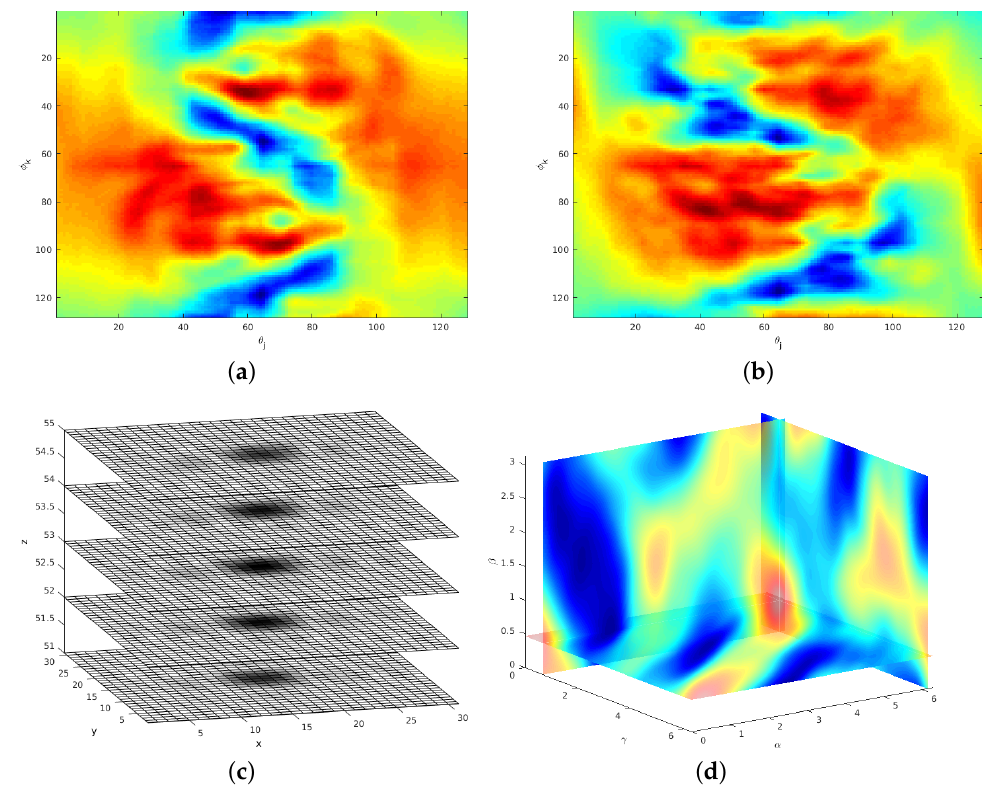
Figure 2. The SO(3) Fourier Transform (SOFT) descriptor functions and registration peaks from a registration example. The transformation parameters are yaw = 30 ◦ , roll = 30 ◦ , pitch = 30 ◦ and scale 30%. The corresponding Magnetic Resonance Tomography (MRT) scan pair is generated from a segmented bone with size N VS = 96. Resulting parameters are yaw = 31.4 ◦ , roll = 28.8 ◦ and pitch = 29.2 ◦ for SO ( 3 ) rotation using a bandwidth BW = 64. ( a ) SOFT descriptor function—scan 1. ( b ) SOFT descriptor function—scan 2. ( c ) Clear 3D translation peak according to a correct registration of an ideal transformation (zoom into inverse 3D FT). ( d ) Maximum of SO ( 3 ) parameter